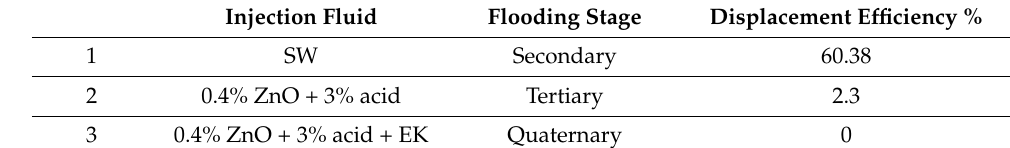
Table 11. Summary of CF4. Table 10. Summary of CF3.